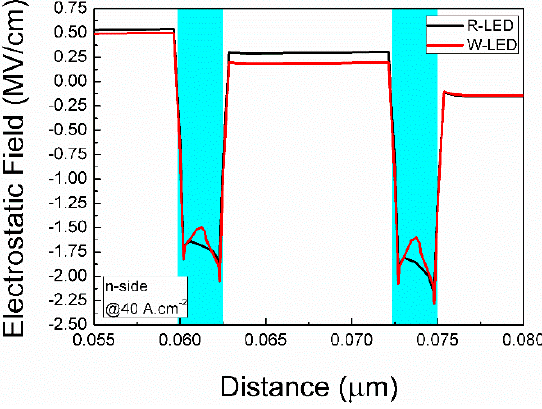
Figure 6. Built-in field comparison of R-LED and W-LED.